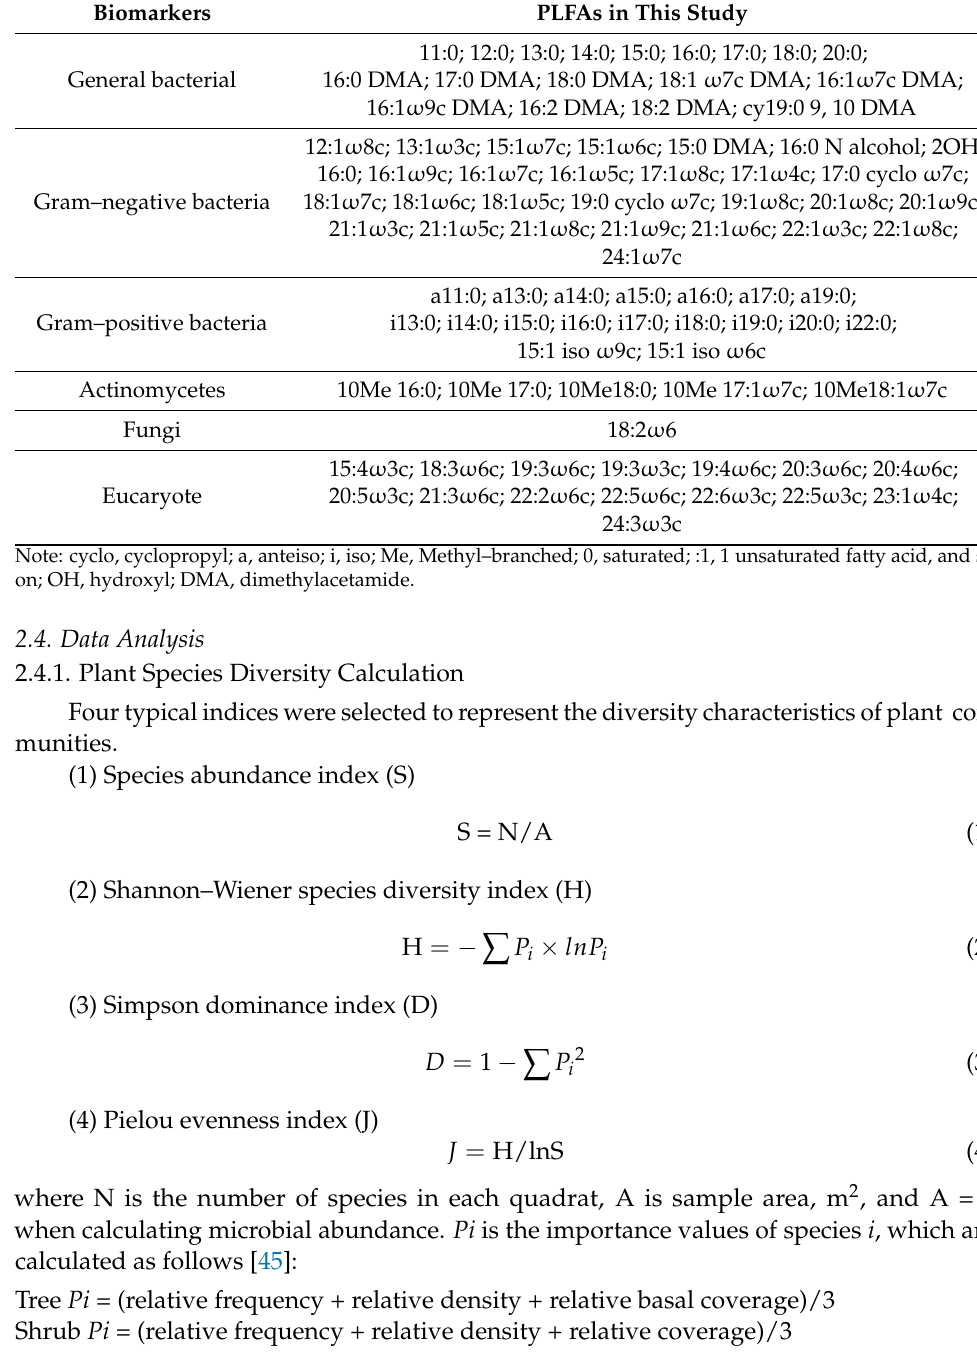
Table 1. Main phospholipid fatty acids used as biomarkers. Biomarkers PLFAs in This